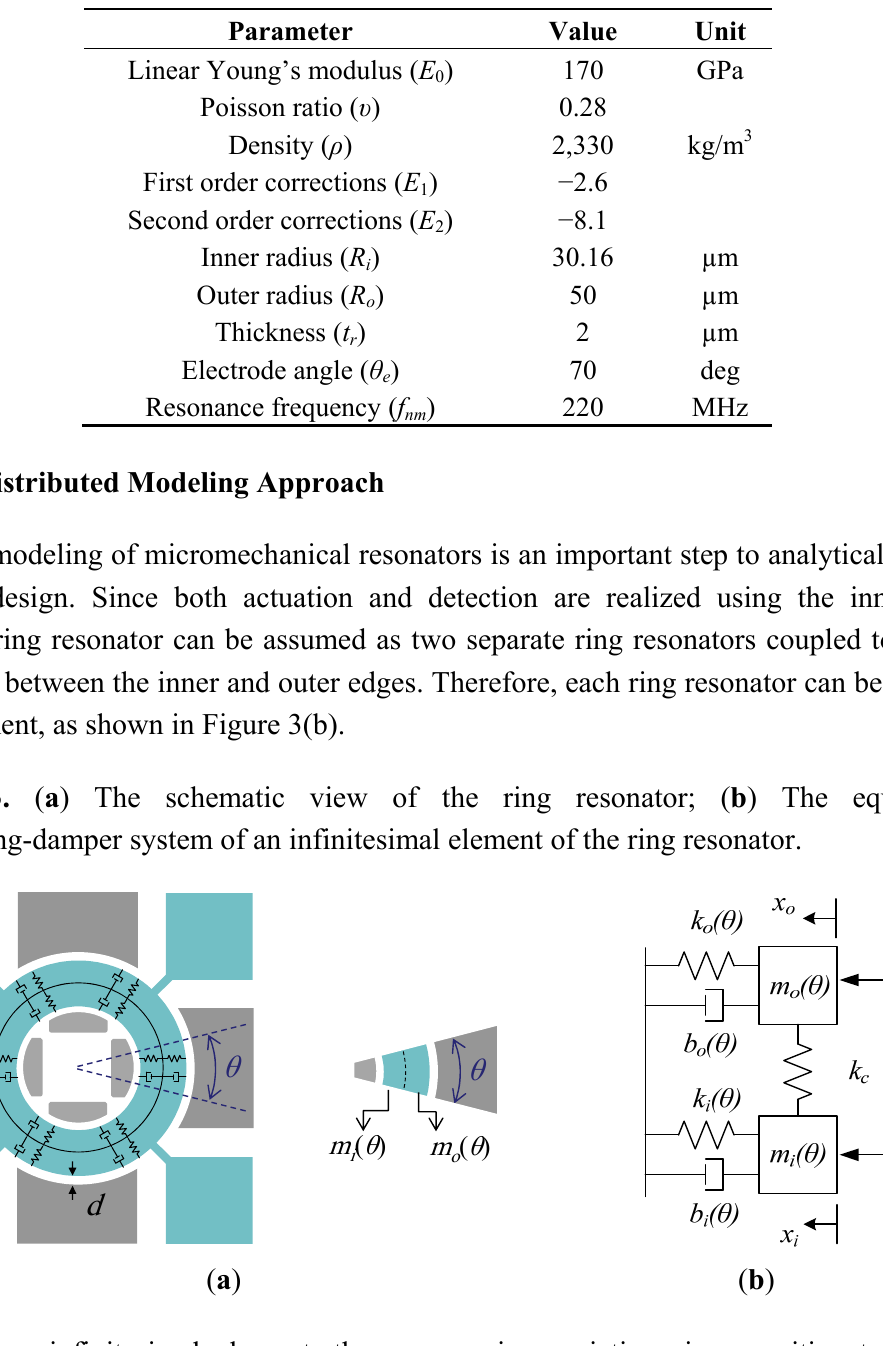
Table 1. The related parameters for silicon ring resonator.